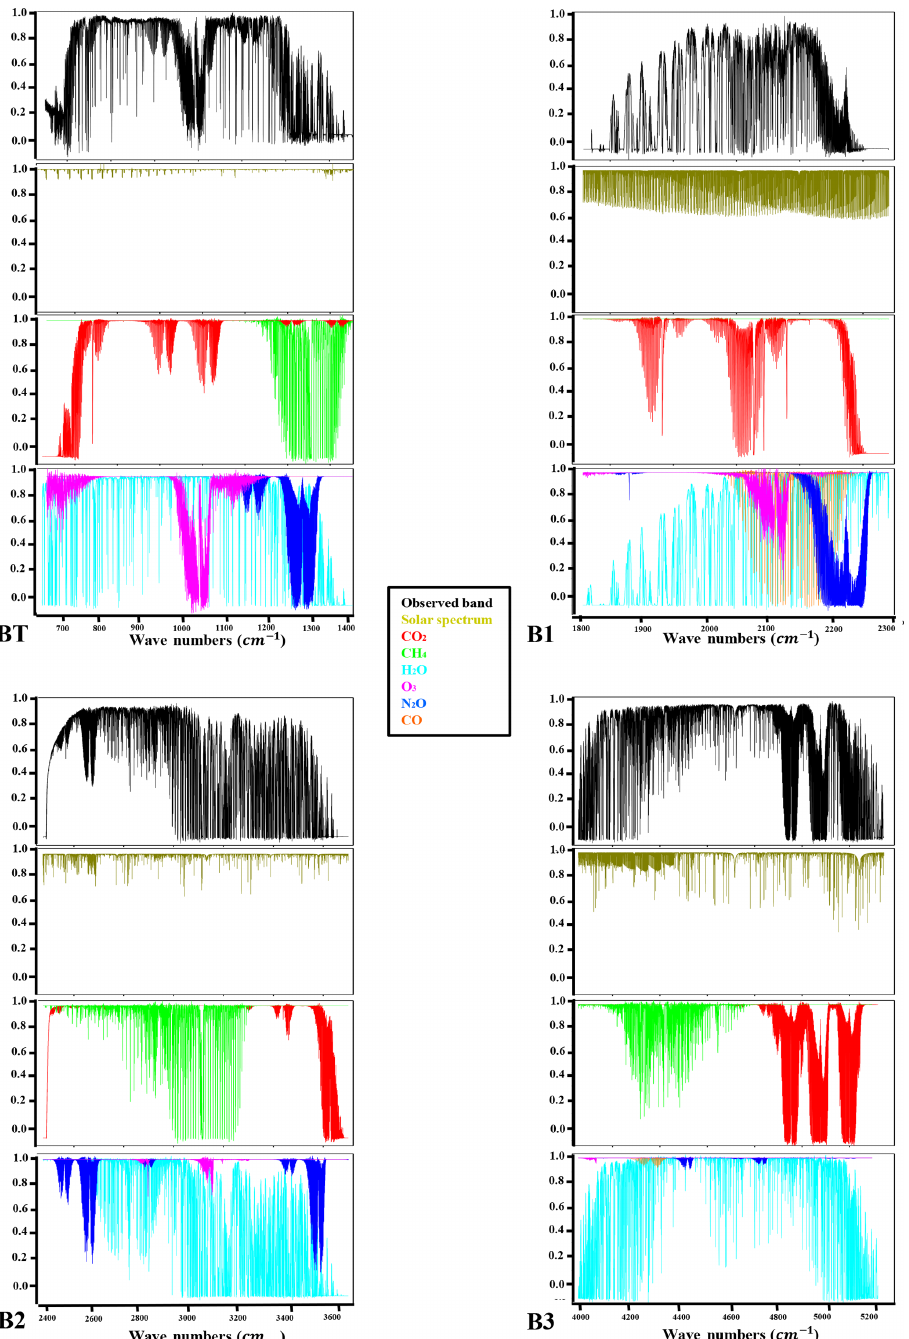
Figure 7. Measured and simulated CHRIS spectrum in transmittance for clear sky conditions at Izaña observatory. Each band is calculated from the line-by-line forward model ARAHMIS and the solar pseudotransmittance spectra reported by Toon (2015).